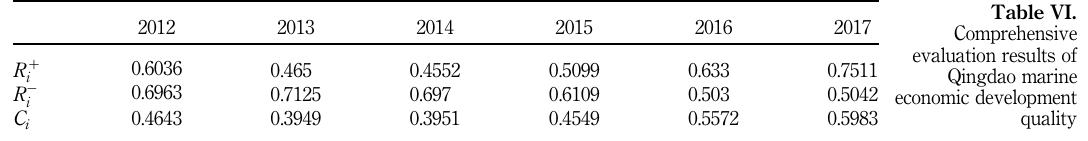
Figure 1. Evaluation results of Qingdao marine economic development